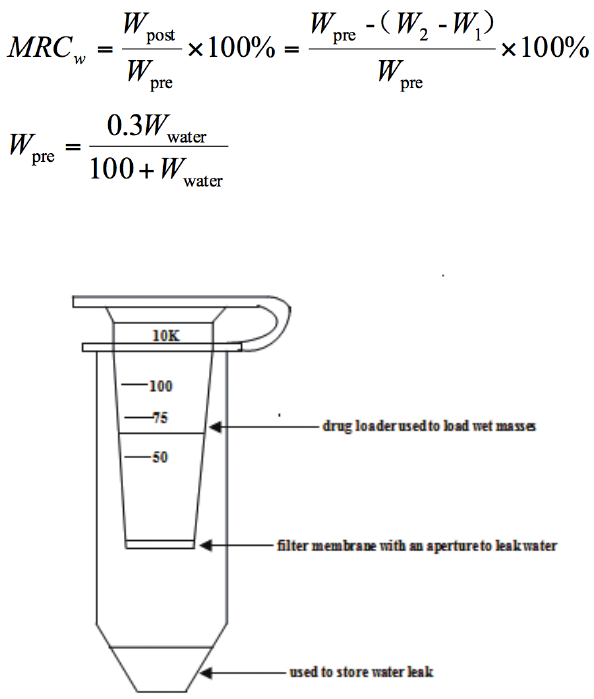
FIGURE 1 - The schematic diagram of ultrafiltration centrifuge